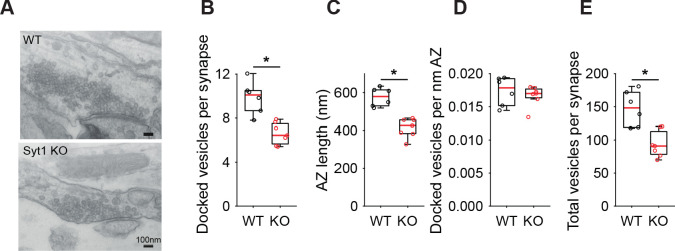
Reduced number of docked vesicles in hippocampal Syt1 KO autaptic synapses.(A) Representative examples of electron microscopy images of WT and Syt1 KO synapses. (B) Boxplots of docked vesicles per synapses, (C) active zone (AZ) length in nm, (D) docked vesicles per nm AZ, and (E) total number of vesicles per synapse in WT and Syt1 KO. (*p<0.05, Wilcoxon rank sum test).
Figure 1—figure supplement 1—source data 1.Statistics overview.